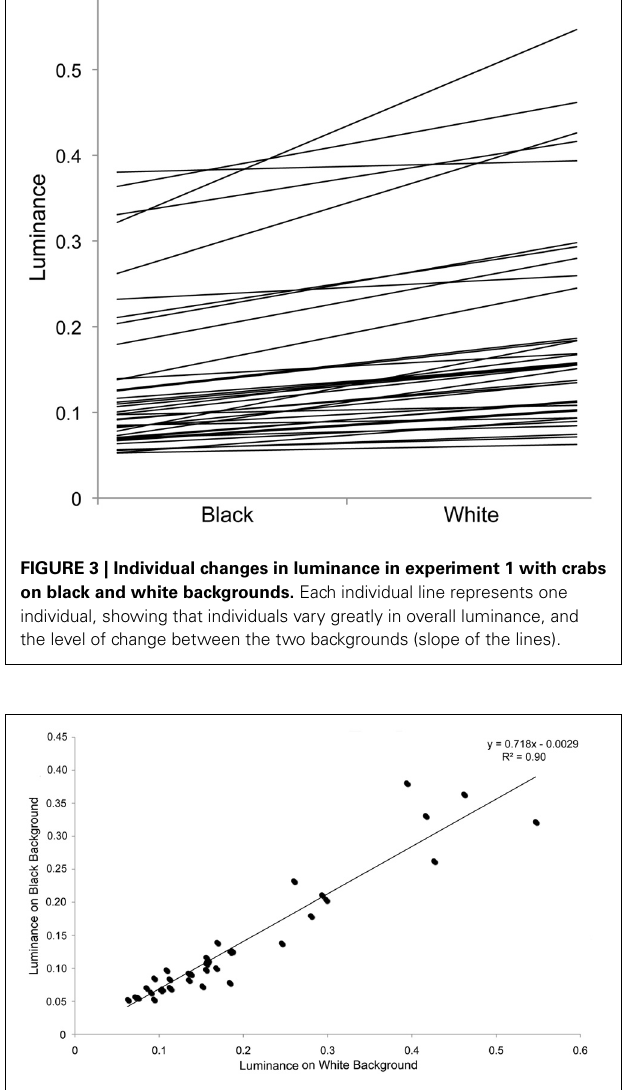
FIGURE 4 | Individual luminance values on black and white backgrounds in experiment 1. There is a very close relationship between the luminance values on individuals against each background, showing that individuals that are relatively bright on one background also tend to be relatively bright on the other background.